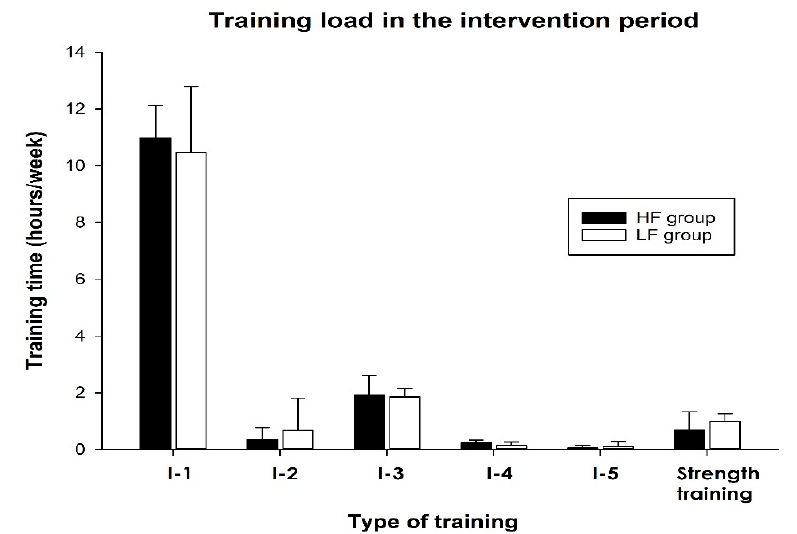
Figure 1. Weekly training load in the 12-week intervention period. The figure shows the distribution of endurance training in the different intensity zones (I-1 to I-5) and duration of strength training in the high- and low-frequency group (HF- and LF group). Values are presented as the median and IQR. There were no statistically significant differences between the groups.